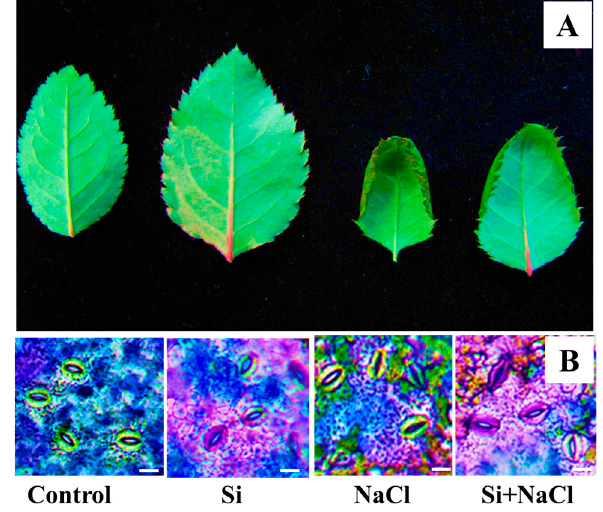
Figure 1. Leaf morphology ( A ) and stomatal structure ( B ) of Rosa hybrida ’Rock’ Fire in response to NaCl stress with and without silicon (Si) supplementation after 15 days. Bars: 100 µm.